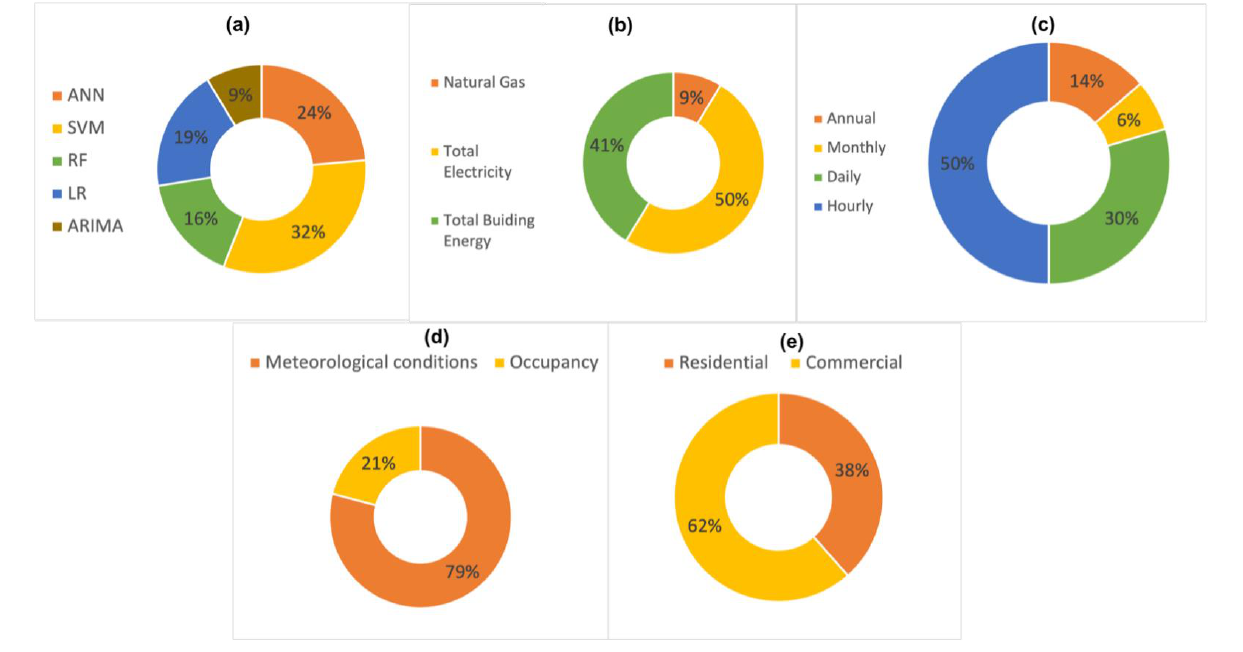
Figure 2. ( a ) Proportion of studies that employed the different data-driven tools ( b ) Proportion of studies that predicted different energy types ( c ) Proportion of studies that predicted different granularity of energy consumption ( d ) Proportion of studies that utilized meteorological and occupancy ( e ) Proportion of studies that employed different types of building.